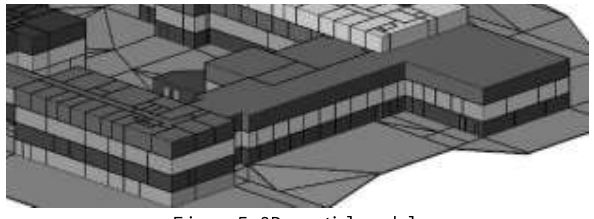
Figure 5. 3D spatial model